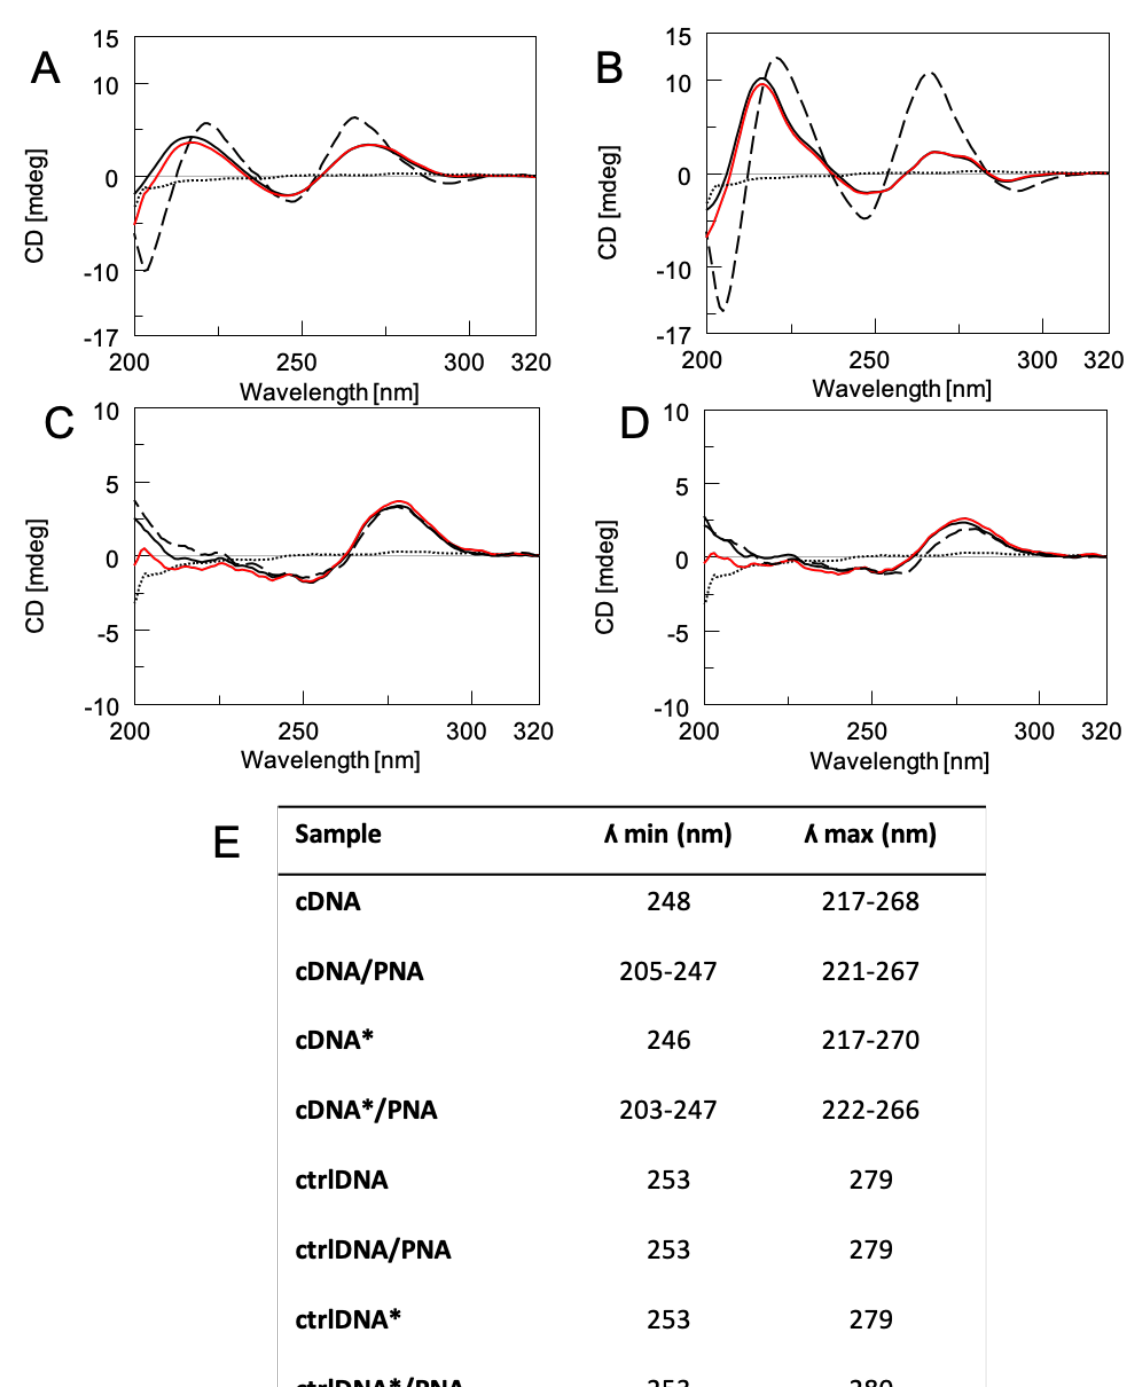
Figure 2. CD spectra of cDNA* and cDNA alone (black solid line, panel A and B , respectively) and after annealing with PNA (dashed line, A and B respectively); ctrlDNA* and ctrlDNA alone (solid black line, panel C and D respectively) and annealed with PNA at pH 7.0 (dashed line, C and D respectively); all samples were dissolved in 100 mM PBS. CD profiles of the arithmetic sum of each ON with PNA are reported as red lines. The CD spectrum of PNA alone is reported as a dotted line. All samples were normalized at 320 nm; Table ( E ) λ values of CD minima and maxima of each sample. The CD melting curves of PNA / cDNA* and PNA/cDNA heteroduplexes revealed The molecular size of the complexes was examined by PAGE analysis (Figure S4). In greater stability of the latter (Tm values of 40 °C and 45 °C, respectively), as also disclosed the case of the cDNA* and ctrlDNA* alone dissolved in 100 mM PBS buffer, one